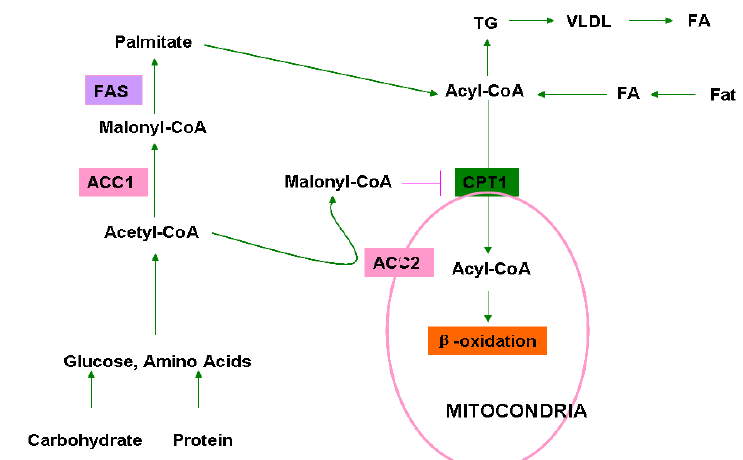
Figure 1. Roles of ACC1 and ACC2 in cellular fatty acid/lipid metabolism. Dietary fats, carbohydrates, and proteins are primary sources of fatty acids (FA), glucose, and amino acids. FA is converted to acyl-CoA in liver, and glucose and amino acid are converted to acetyl-CoA in the liver and adipose. In the cytosol, acetyl-CoA is carboxylated to malonyl- CoA by ACC1 which is utilized by fatty acid synthase (FAS) to produce palmitate, the end product of fatty acid biosynthesis. Palmitate is further converted to various acyl-CoA by elongase and desaturase. Acyl-CoA is shuttled into the mitochondria through carnitine/palmitoyl-transferase 1 (CPT1) for β -oxidation. Acyl-CoA could also be utilized for the synthesis of triglycerides (TG) in adipose tissues. Acetyl-CoA is also carboxylated by ACC2 at the mitochondrial membrane to generate malonyl-CoA, which inhibits acyl-CoA transfer and oxidation in